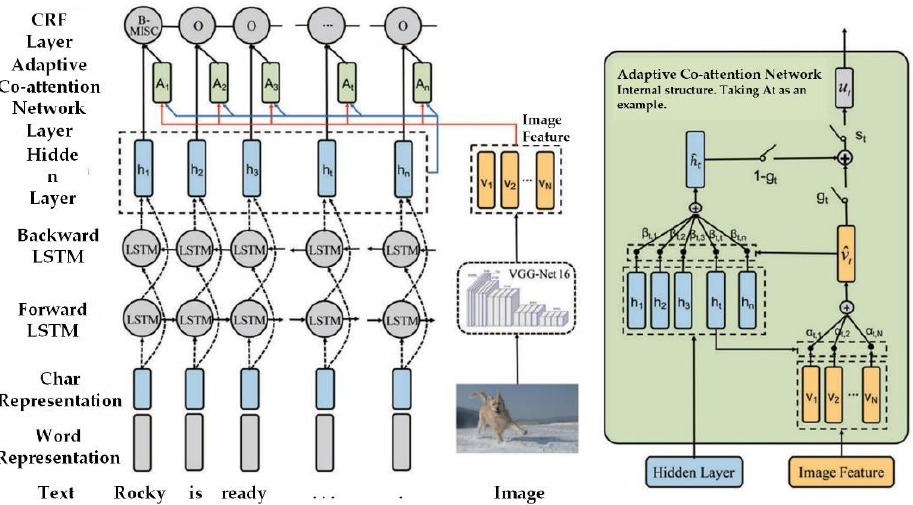
Figure 10. The general architecture of ACN. An adaptive co-attention network layer was inserted between the hidden and CRF layers to pay mutual attention to the representation of text and pictures [98].